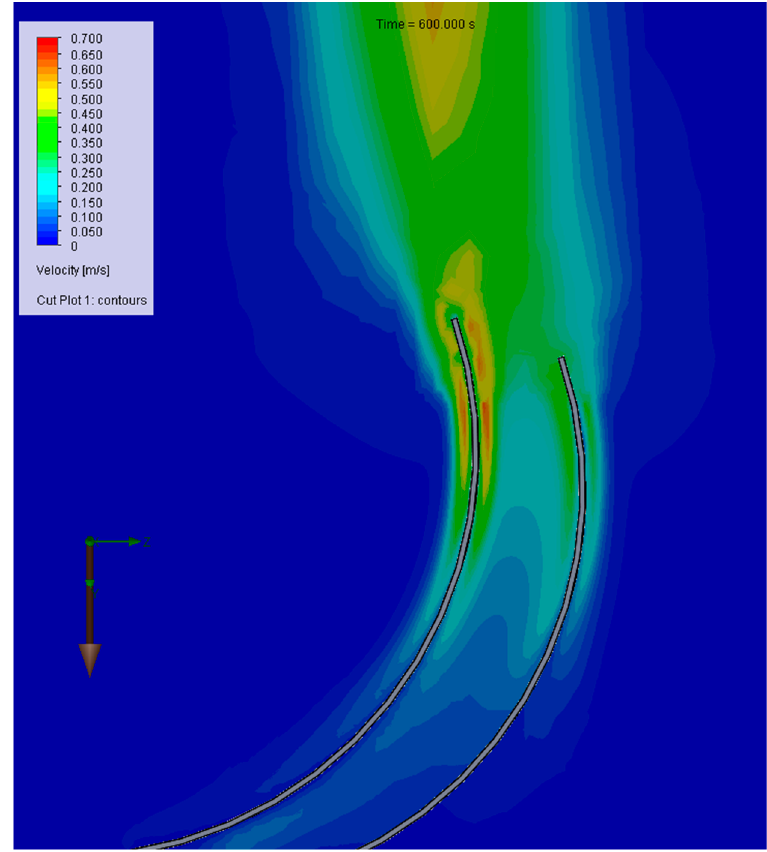
Figure 26. Distribution of velocities on the symmetry plane.